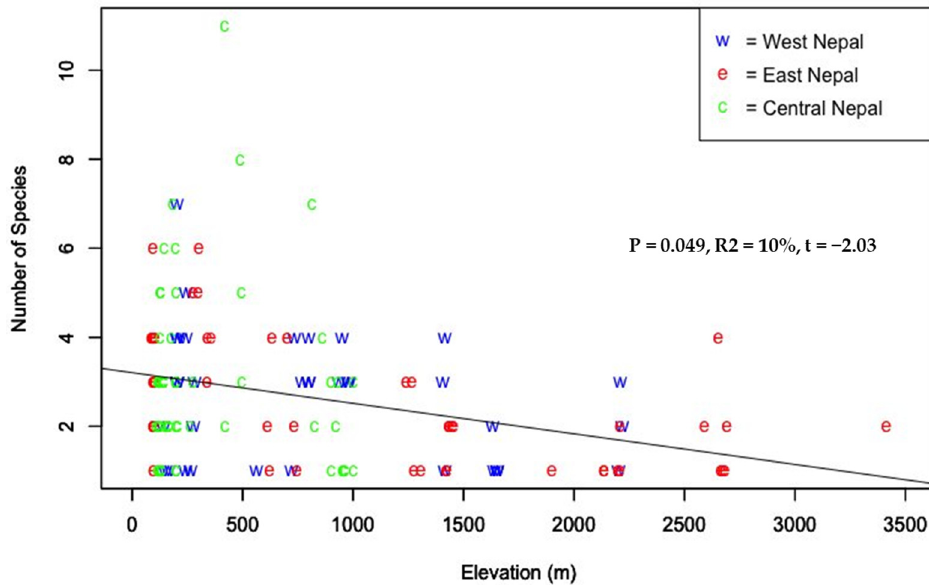
Figure 4. Species richness of ants along elevation gradient in Nepal.